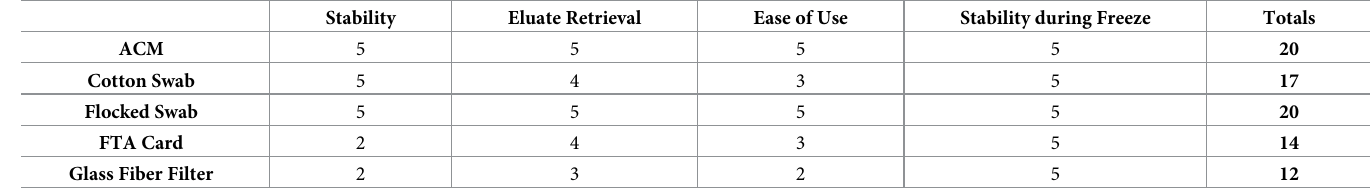
Table 4. Qualitative characteristics of each capture media tested and ratings of four factors based upon common laboratory